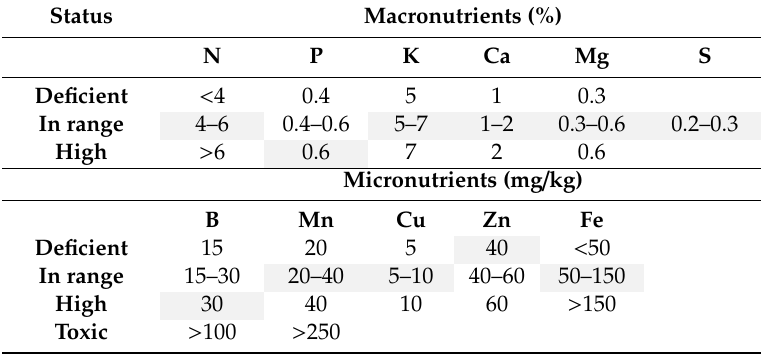
Table A1. Early-heading leaf macronutrient and micronutrient optimum concentration ranges in butterhead lettuce. Grey sections indicate nutrient concentrations range under 20 mM HCO